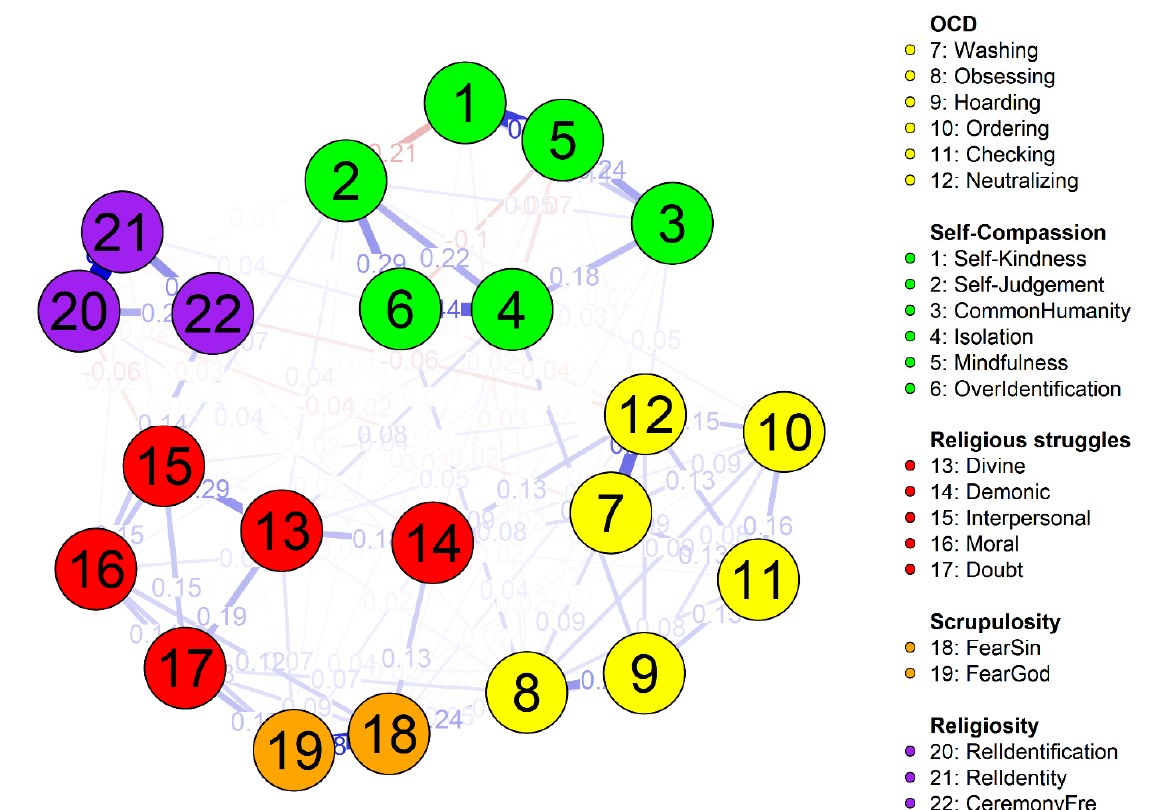
Figure 2. The regularized partial correlation network. (Different colors represent different groups of symptoms according to the legend; blue edges represent positive, while red edges represent negative associations between nodes; numbers indicate partial correlations between nodes.).